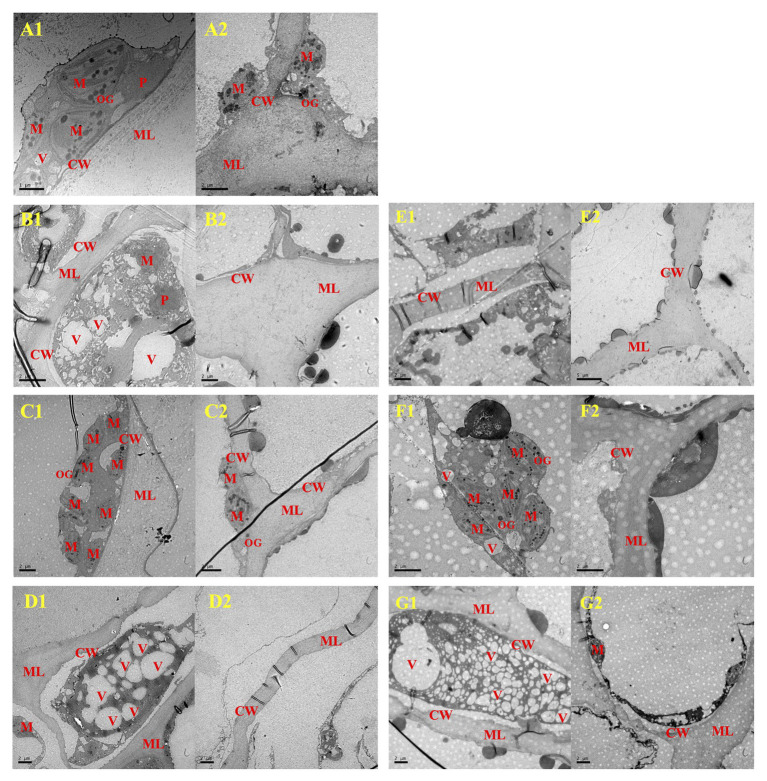
The cellular ultrastructure of A. alternata- (B–D) and B. cinerea- (E–G) inoculated blueberry fruit after treatment with ethanol on the 8th day of storage at 0±0.5°C. A1 and A2, Wound-Control; B1 and B2, A-Control; C1 and C2, A-500; D1 and D2, A-1000; E1 and E2, B-Control; F1 and F2, B-500; G1 and G2, B-1000. CW, cell wall; M, mitochondria; ML, middle lamella; P, plastid; V, vacuole. The scale bars for A1 represents 1μm, for (A2,B1,B2,C1,C2,E1,F1,F2,G1,G2) represent 2μm, and for E2 represents 5μm.